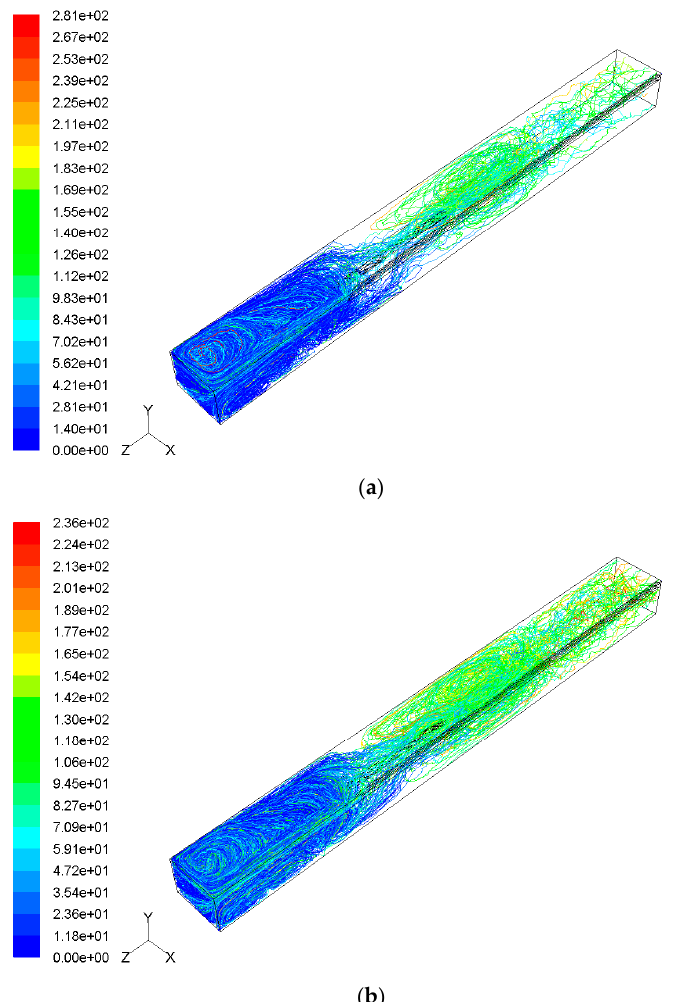
Figure 12. Coal dust trajectories for long blowing and short suction ventilation system colored by particle residence time(s). ( a ) Total coal dust particle trajectories; ( b ) respirable coal dust